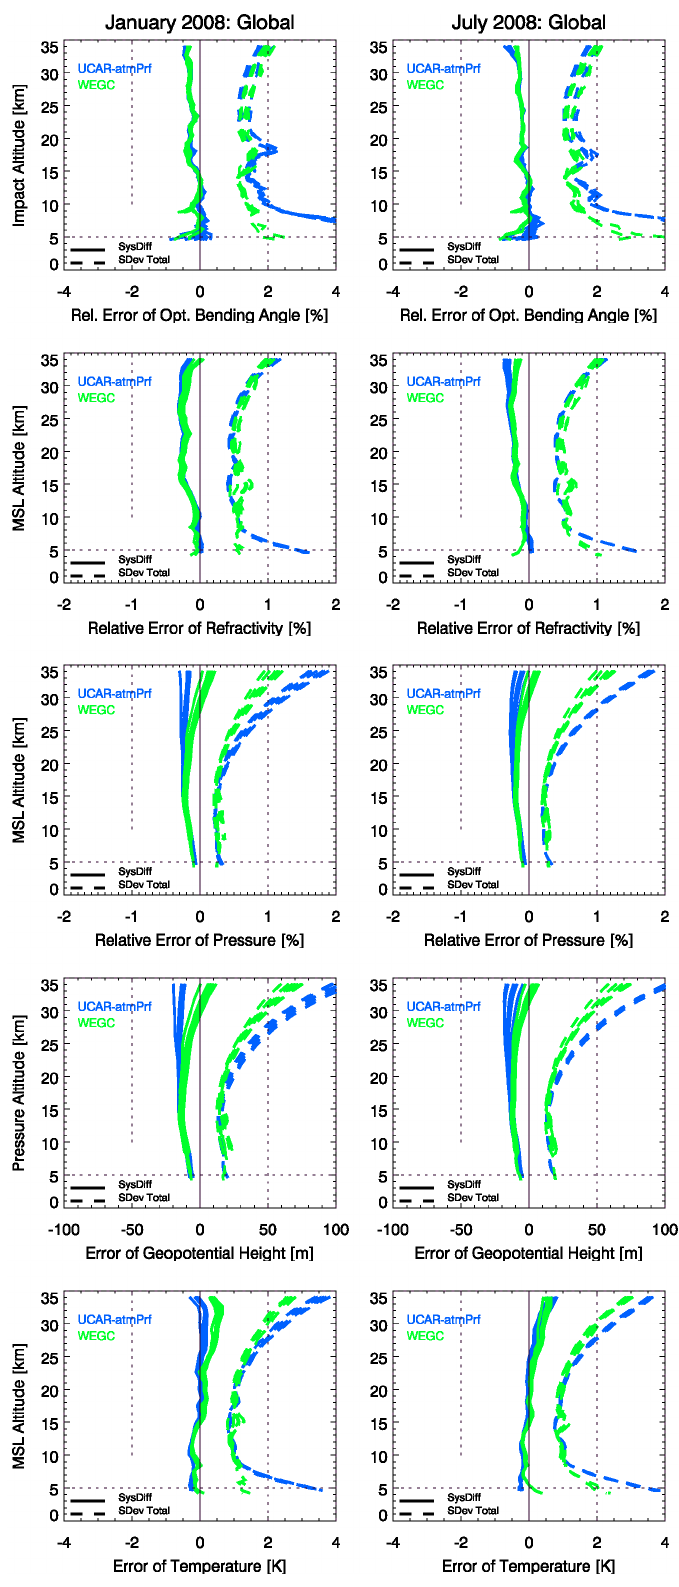
Fig. 3. UCAR (blue) and WEGC (green) CHAMP, GRACE-A, and F3C systematic difference (solid) and standard deviation (dashed) relative to ECMWF. Optimized bending angle, refractivity, dry pressure, dry geopotential height, and dry temperature statistics are shown for January 2008 (left panels) and July 2008 (right